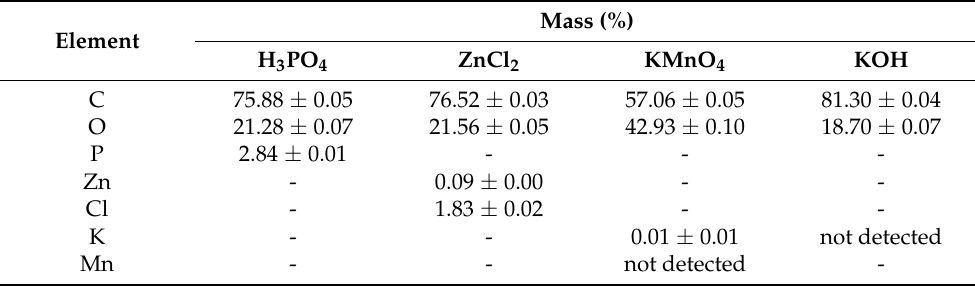
Table 2. Elemental composition of activated carbons from sago waste prepared using various chemical activating agents.